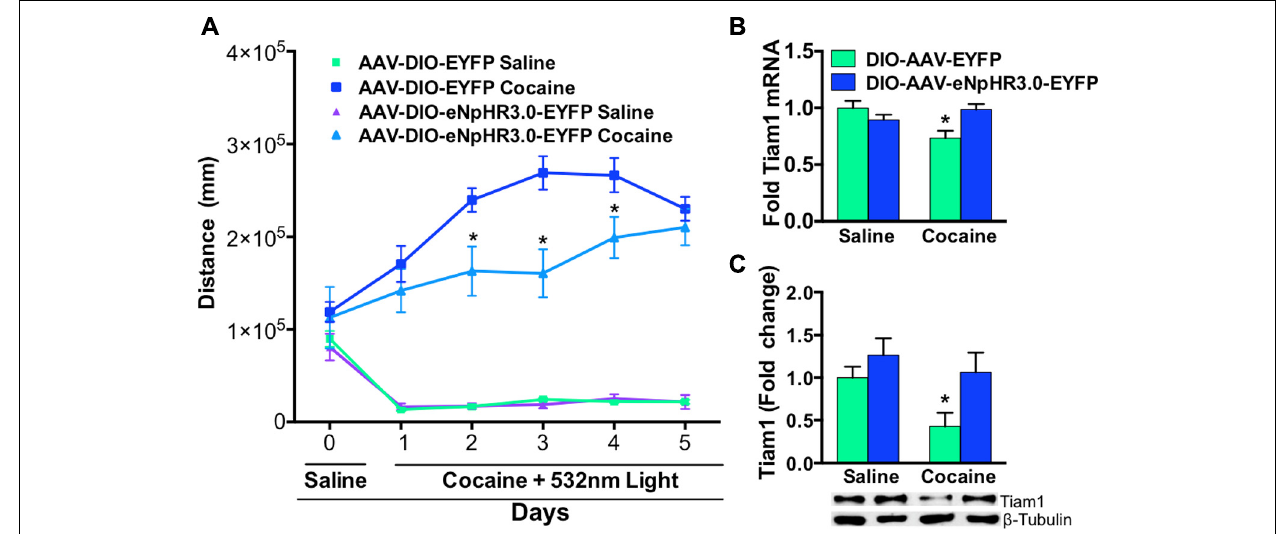
FIGURE 4 | Optogenetic inhibition of NAc D1-MSNs attenuates cocaine locomotor sensitization and reversesTiam1 gene expression. (A) D1-Cre mice expressing AAV-DIO-eNpHR3.0-EYFP or AAV-DIO-EYFP in NAc were injected (i.p.) with saline (day 0) followed by injections (i.p.) with either cocaine (10 mg/kg) or saline coupled with green light illumination to the NAc and locomotor activity was monitored for 1 h (days 1–5, n = 4–7 per group). D1-MSN inhibition in the AAV-DIO-eNpHR3.0-EYFP cocaine group resulted in a significant attenuation in cocaine locomotor activity on days 2–4 compared to the AAV-DIO-EYFP cocaine group. (Repeated measure two-way ANOVA,